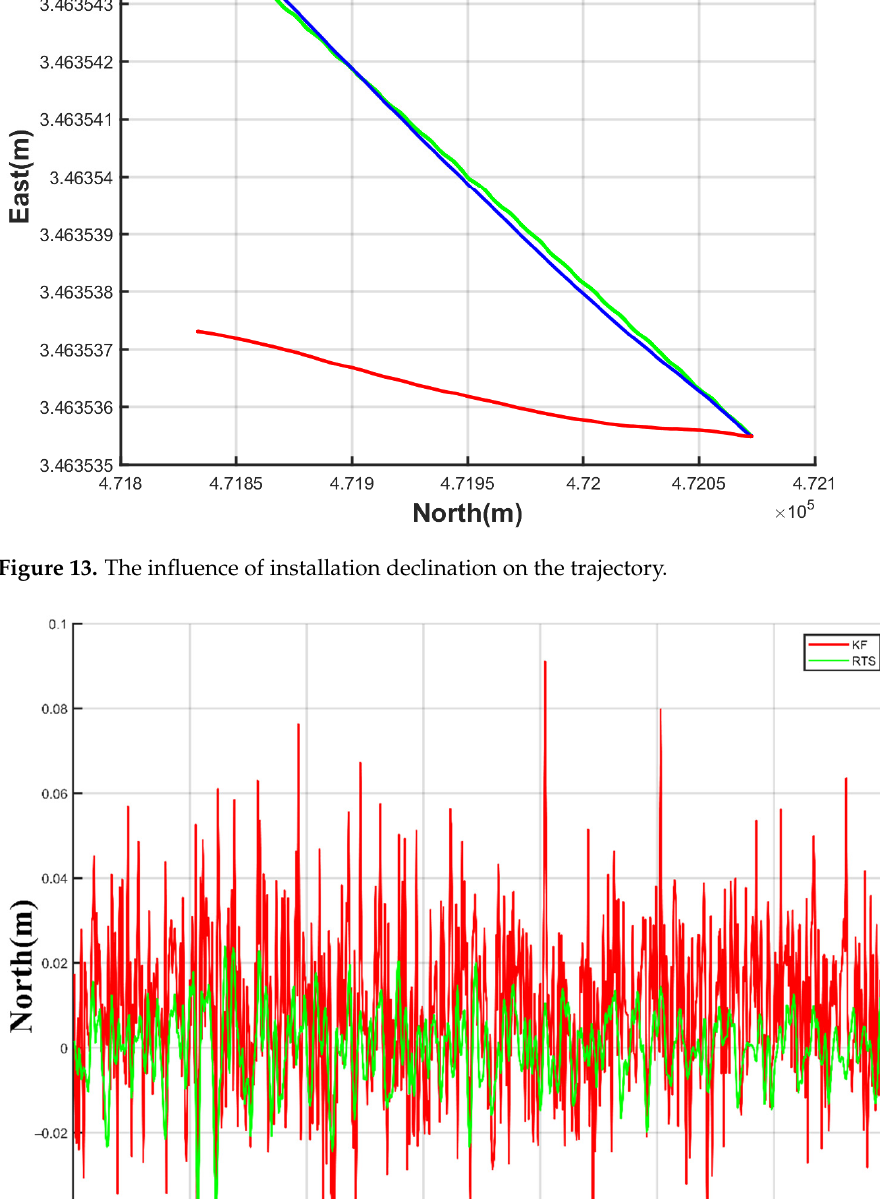
Figure 15. Comparison of eastward error between the KF and RTS.